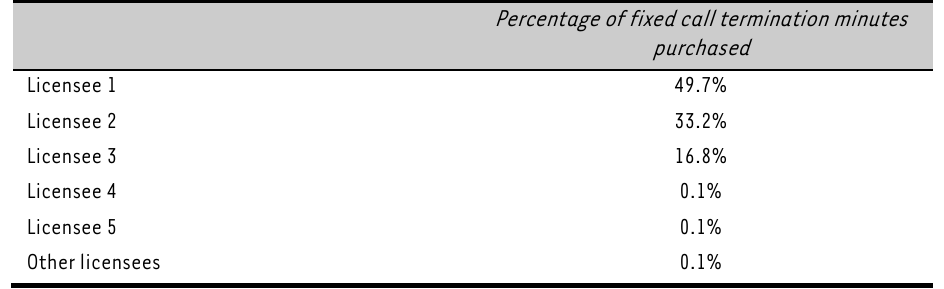
Proportion of fixed terminating minutes purchased by each licensee, January to June